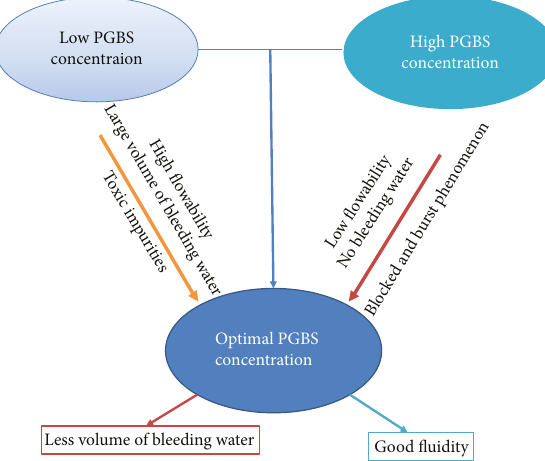
Figure 2: Optimal PGBS